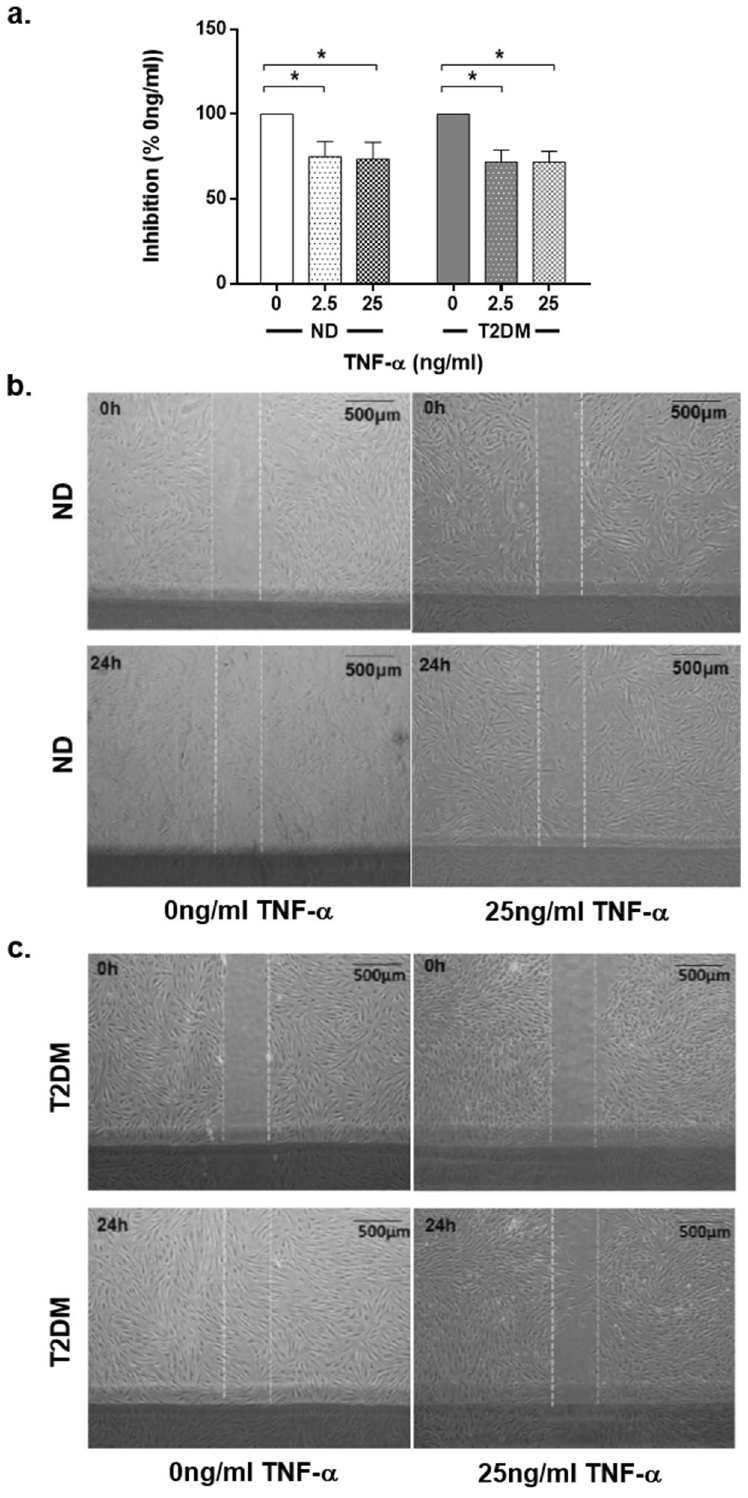
Figure 3. Migratory capacity of ND-DF and T2DM-DF. ( a ) Confluent cells were quiesced for 24 h before being scratched, stimulated ± 0–25 ng/ml TNF-α and imaged. Repeat images were taken of the same wounds 24 h later. The percentage inhibition of TNF-α on migration was calculated by dividing the distance migrated in control cells by the distance migrated in treated cells (both n = 4 donors). ( b ) ND-DF representative images, ( c ) T2DM-DF representative images. Two-way ANOVA with Sidak post-hoc test, * P < 0.05, ns =